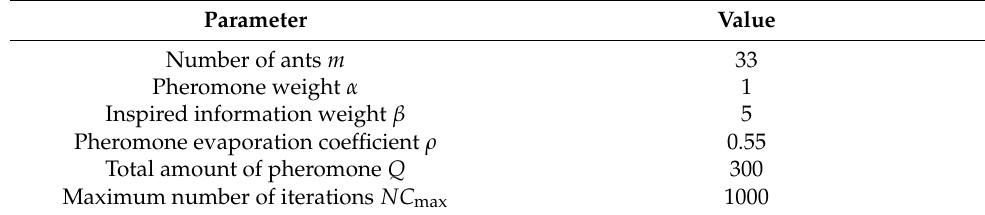
Table 2. Parameter settings of the IACO algorithm.